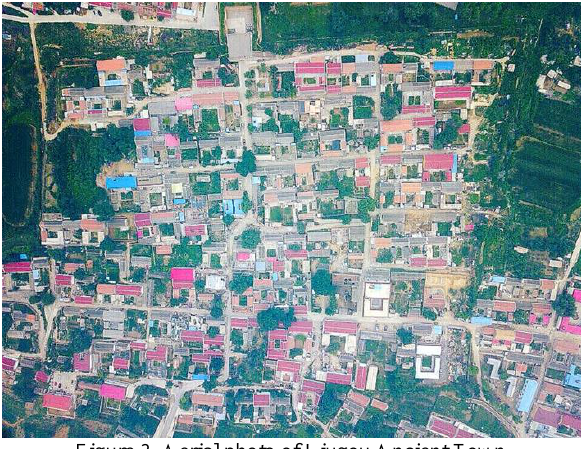
Figure 3. Aerial photo of Liugou Ancient Town.